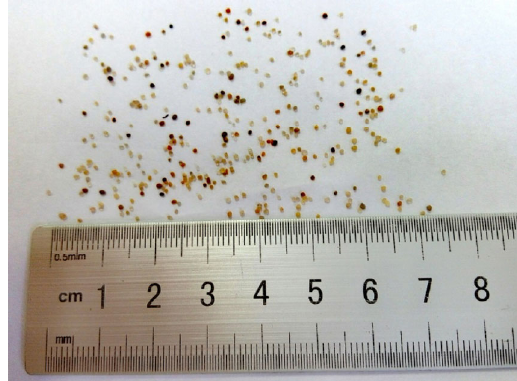
Fig. 3 Sand particles used in this